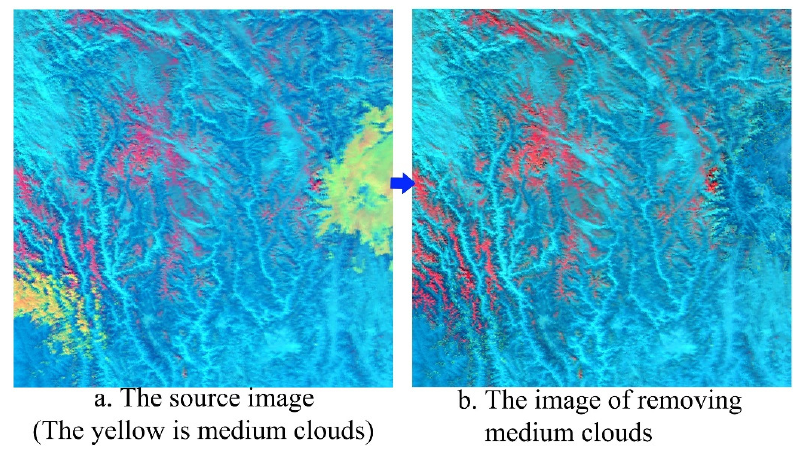
Figure 4. The medium-cloud-removed image ( a ) and its source image ( b ).